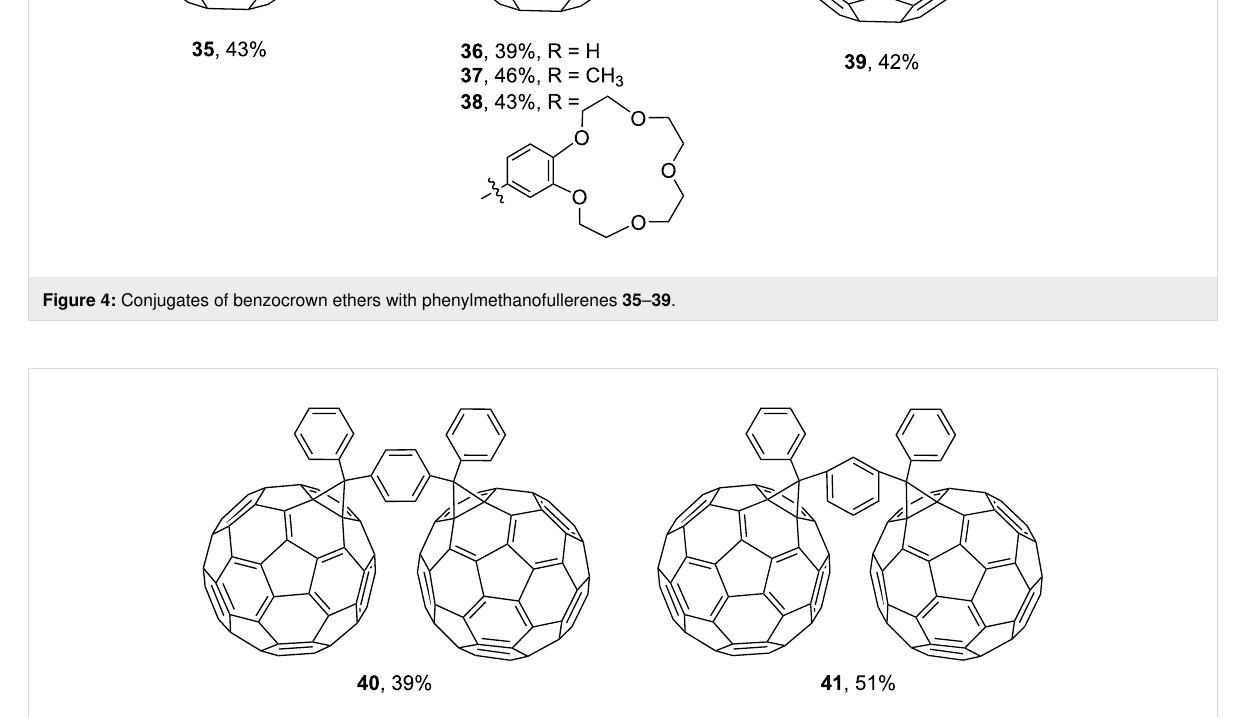
Figure 5: Structures of para -phenylenebis(phenylfulleroid) 40 and meta -phenylenebis(phenylfulleroid) 41 .